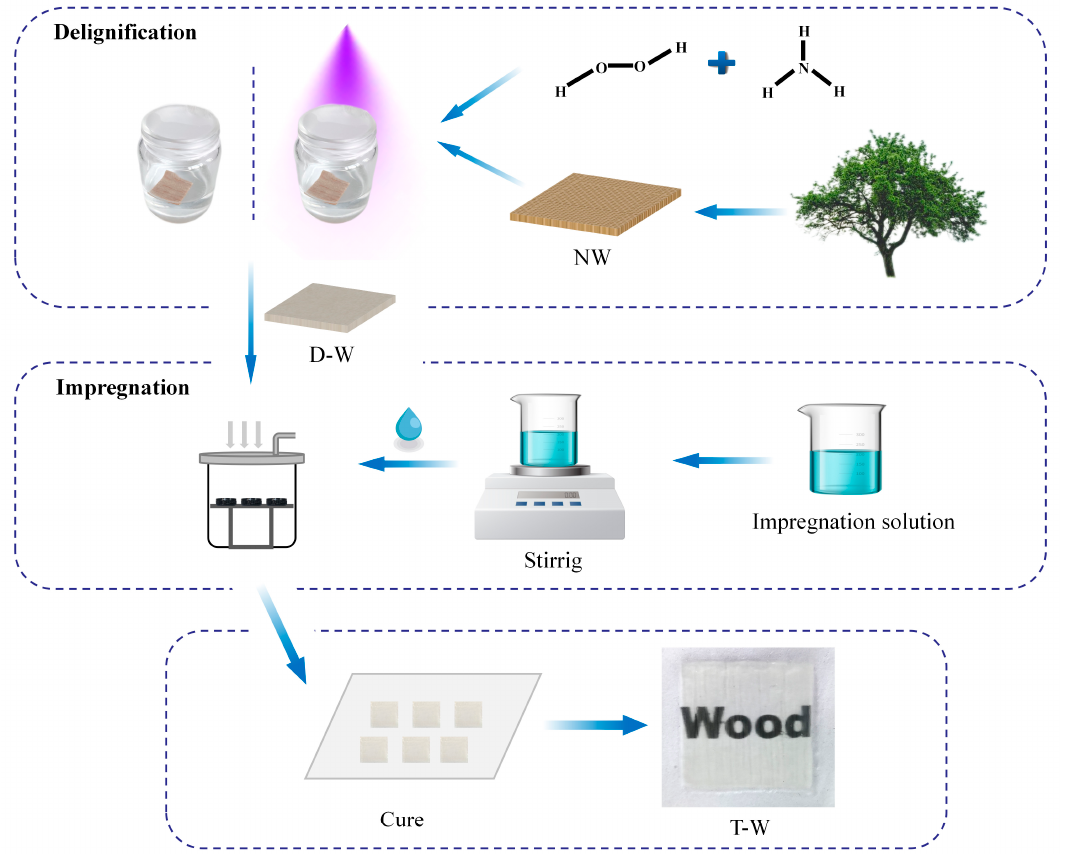
Figure 1. A detailed flow chart for the preparation of “transparent